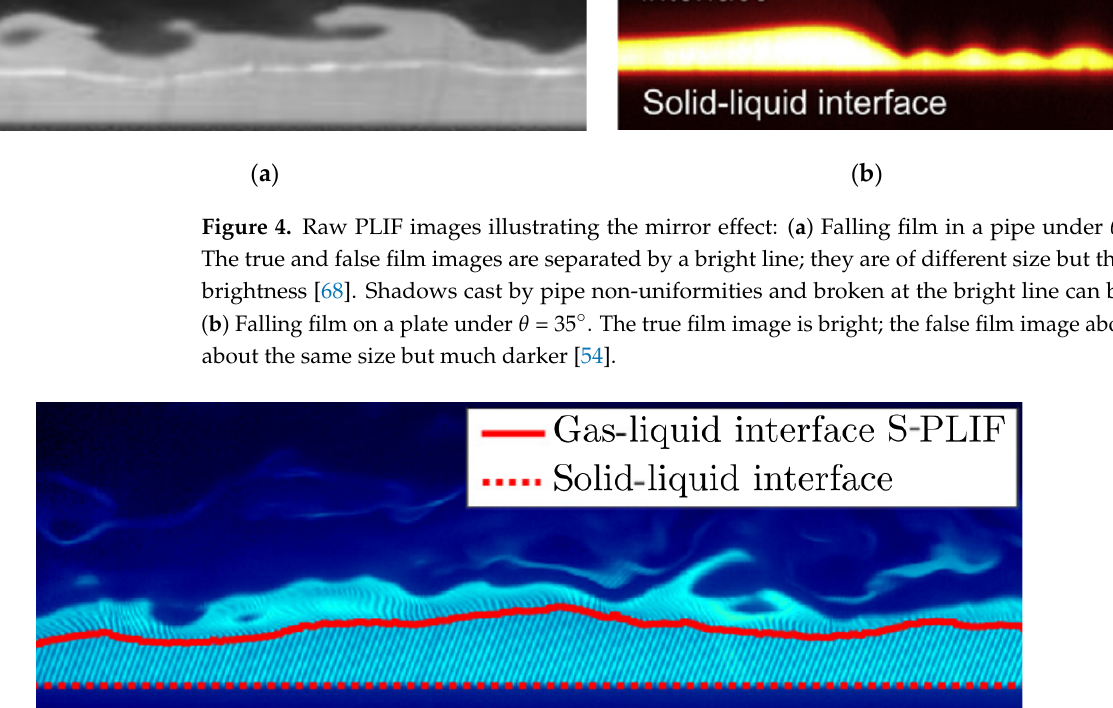
Figure 4. Raw PLIF images illustrating the mirror effect: ( a ) Falling film in a pipe under 𝜃 = 70°. The true and false film images are separated by a bright line; they are of different size but the same brightness [68]. Shadows cast by pipe non-uniformities and broken at the bright line can be seen; ( b ) Falling film on a plate under 𝜃 = 35°. The true film image is bright; the false film image above it is about the same size but much darker [54].